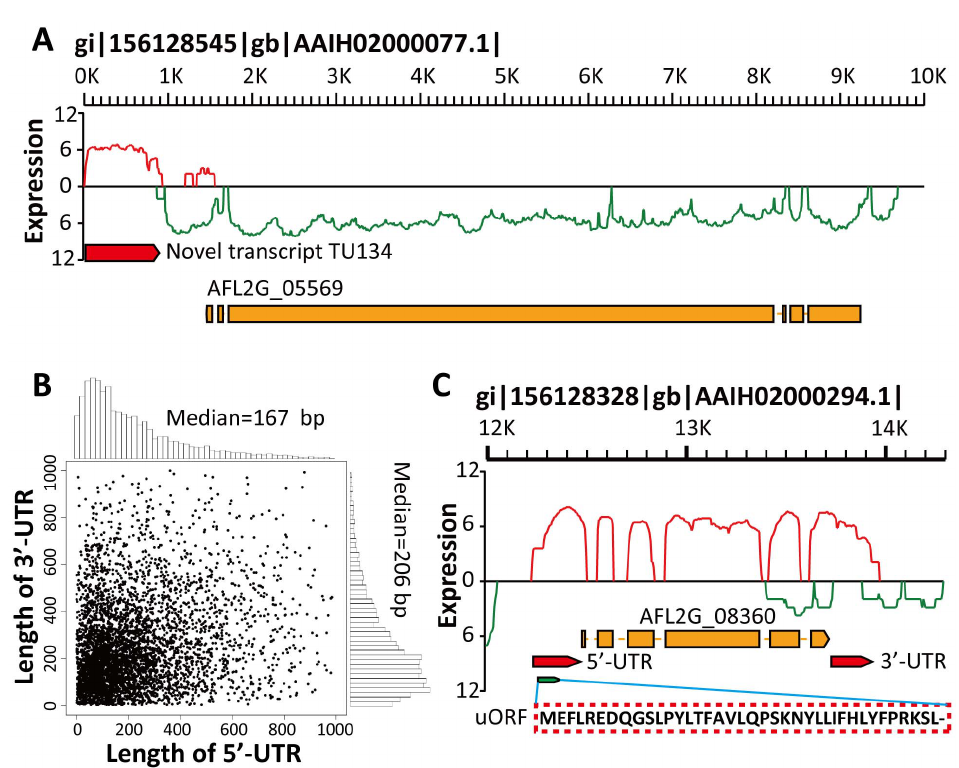
Figure 3. Detailed annotation of the A. flavus gene model. (A) A novel transcript (TU134) identified in contig gi|156128545|g- b|AAIH02000077.1| in the forward orientation. Red bar, the novel transcript TU134 identified in the mycelia sample. Red curve, expression level (log 2 - transformed reads count) of the transcripts located in the forward strand. Green curve, the expression level of the transcripts located in the reverse strand. (B) Scatterplot and histograms showing the length distribution of the 5 9 - and 3 9 -UTRs of A. flavus CA43 genes. (C) UTR and uORF illustration for an annotated A. flavus gene (AFLG2_08360).